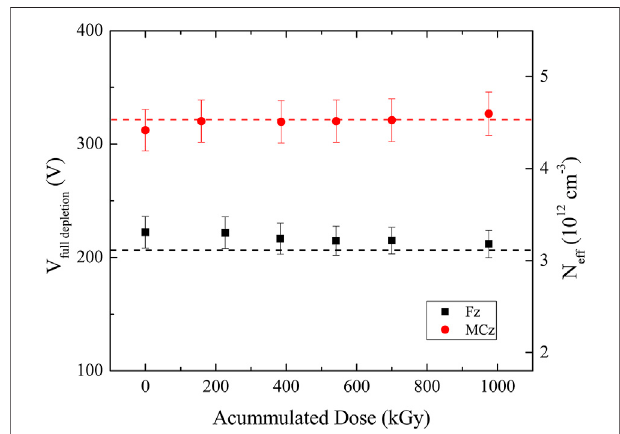
FIGURE12| Fulldepletionvoltagesandeffectivedopingconcentrations (right axis) of pristine MCz and Fz diodes and irradiated up to 975 kGy in incremental steps of almost 150 kGy. The dashed lines indicate the values obtained for the MCz and Fz silicon substrates.